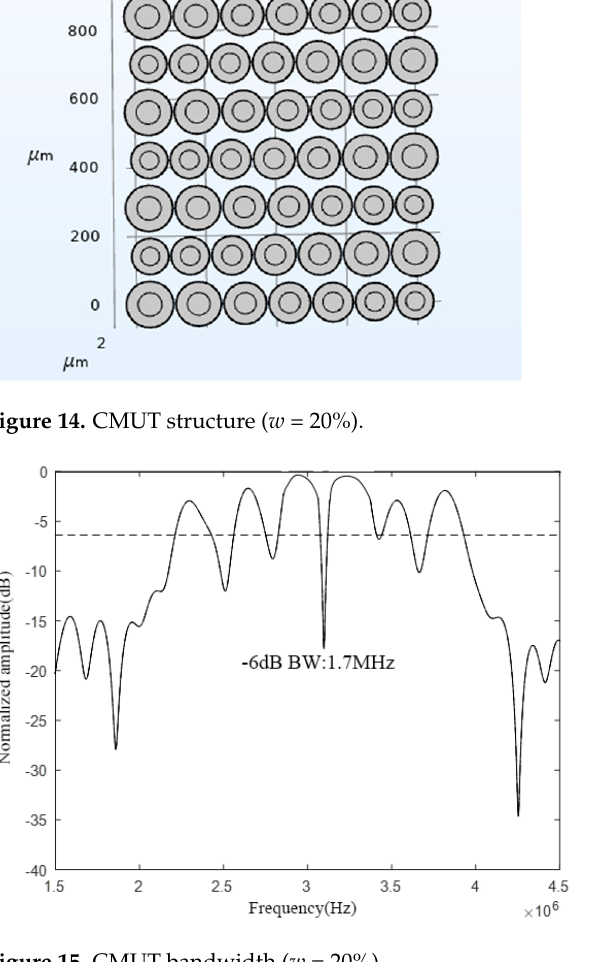
Figure 16. CMUT structure ( w = 50%). Figure 17. CMUT bandwidth ( w = 50%).